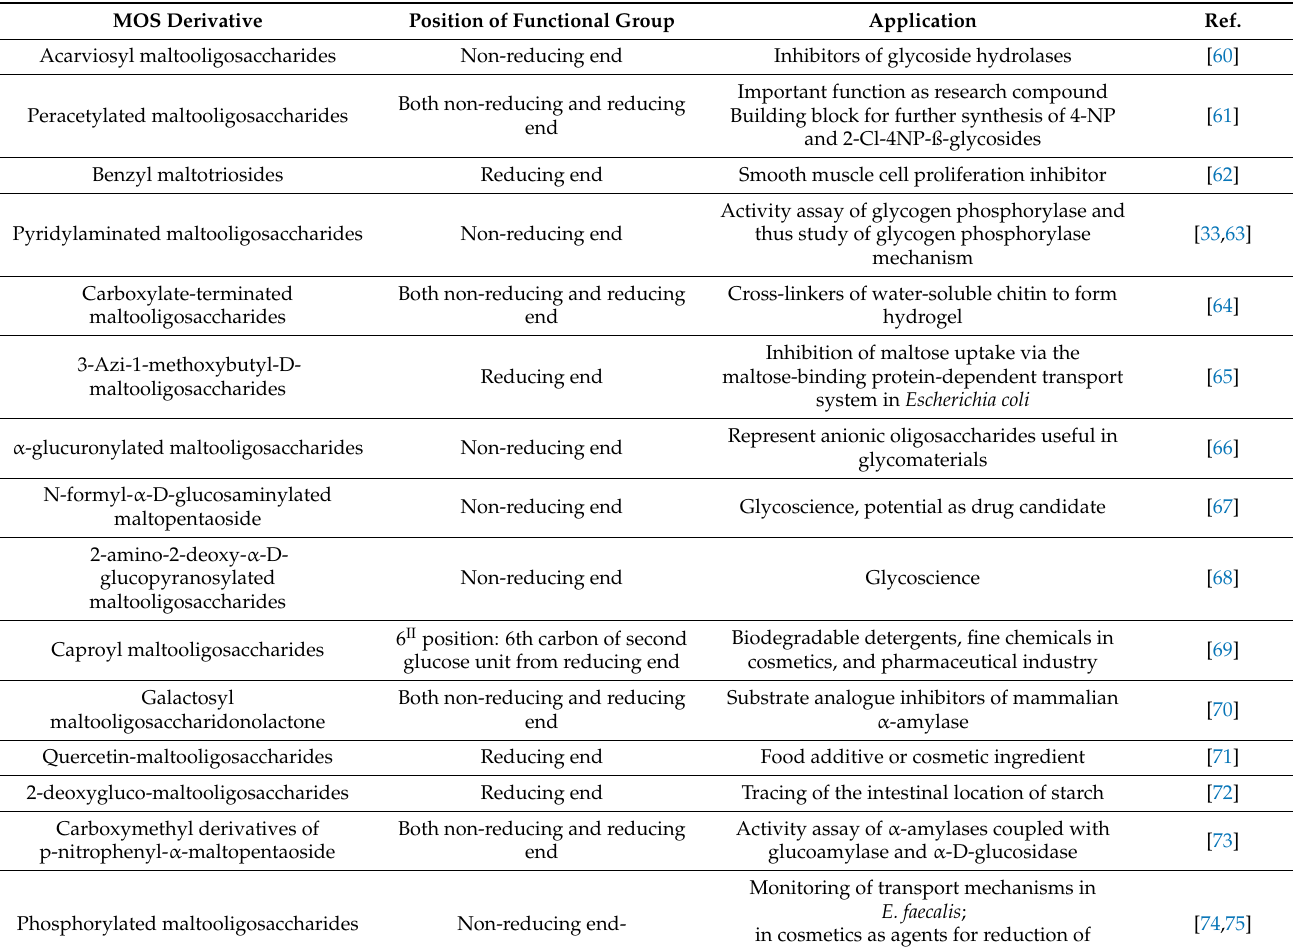
Table 2. Minor derivatives of MOS .